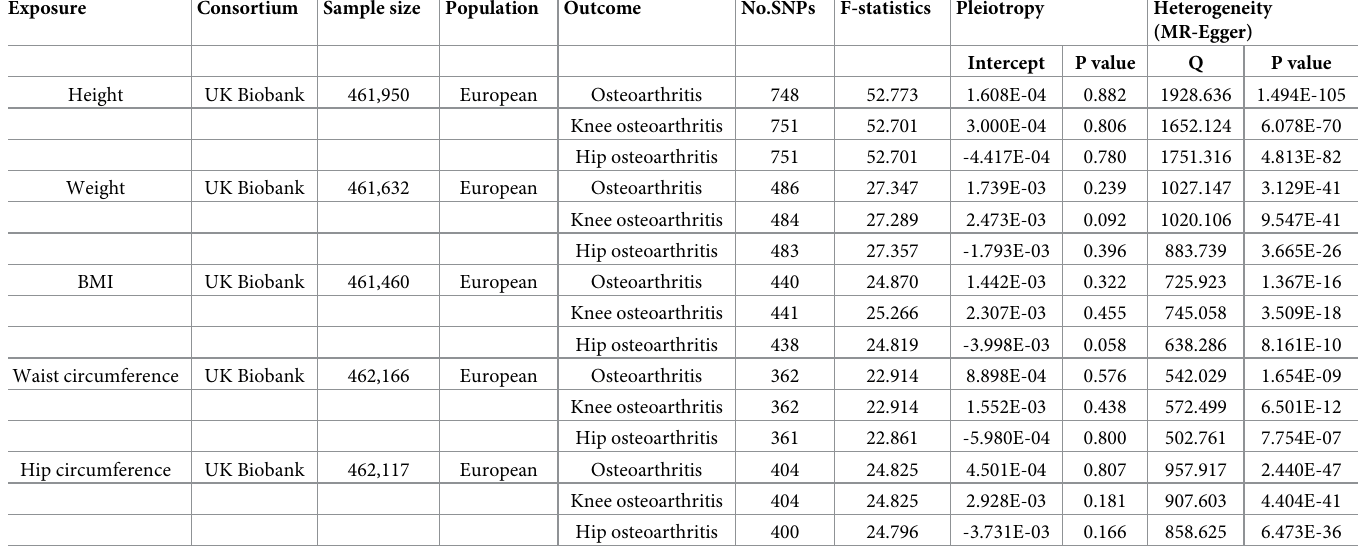
Table 1. Details of the instruments used for